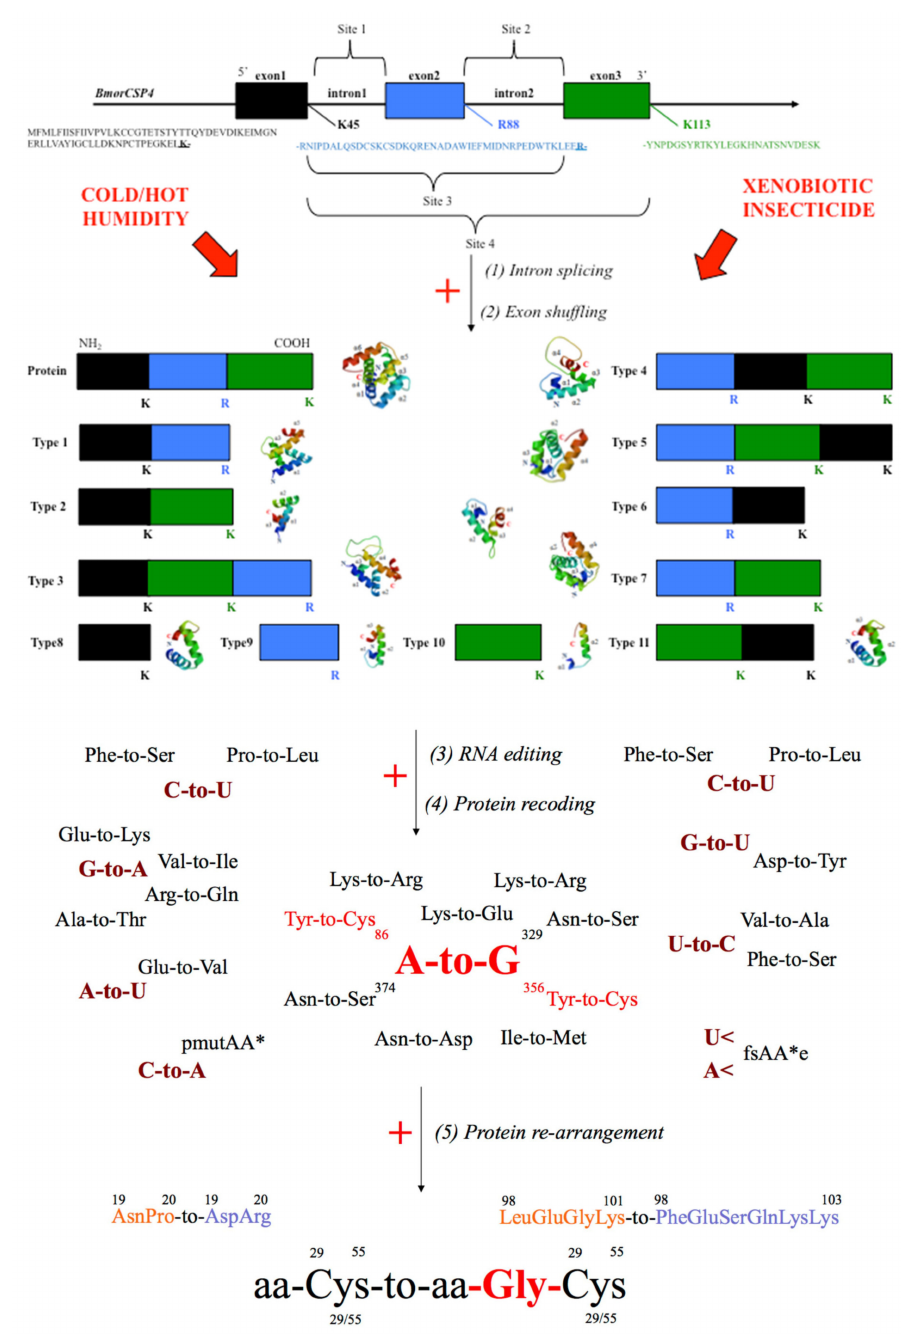
Figure 1. Gene splicing and RNA editing mechanism for diversification of chemosensory proteins (CSPs) under environmental change. An insect CSP gene structure such as lepidopteran BmorCSP4 contains 2 introns and 3 exons [13,14]. (1) Genomic DNA (bold black line) is transcribed into premature mRNA yielding four possible sites for intron splicing. (2) The native protein sequence and eleven types of protein sequence variants can be produced by intron splicing, excision of non-coding regions (intron boundaries: K45, R88 and K113) and shu ffl ing of coding regions (exon1 in black, exon2 in blue and exon 3 in green box). The folded shape of BmorCSP4 and a number of 11 new protein foldings (11 variants) can be generated from gene splicing. (3) The primary transcripts that are a faithful copy of the gene and variant mRNAs are all subject to further typo RNA editing, resulting in an increased number of genetic variants and protein subtypes [13,16–20]. Each mRNA is subject to mutations (A-to-G,